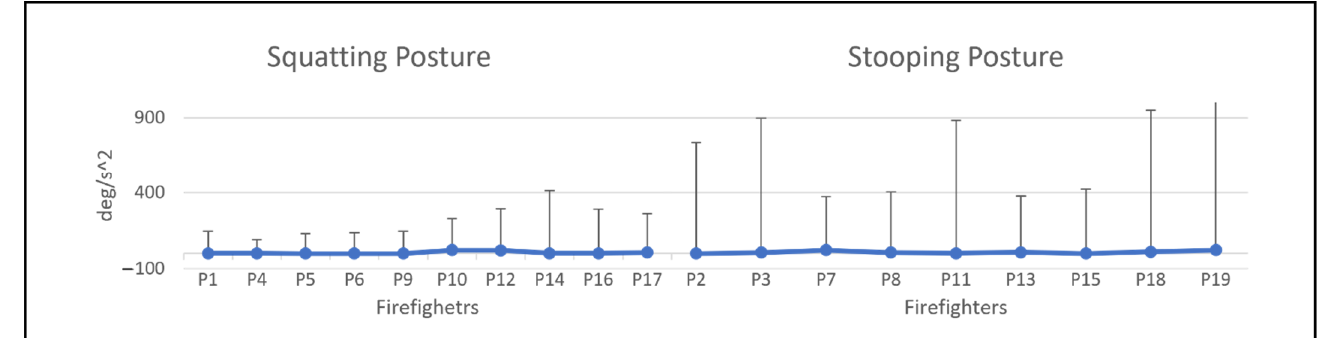
Figure 9. Average and standard deviation of the angular acceleration of FFs for squatting and stooping posture during lifting. stooping posture during